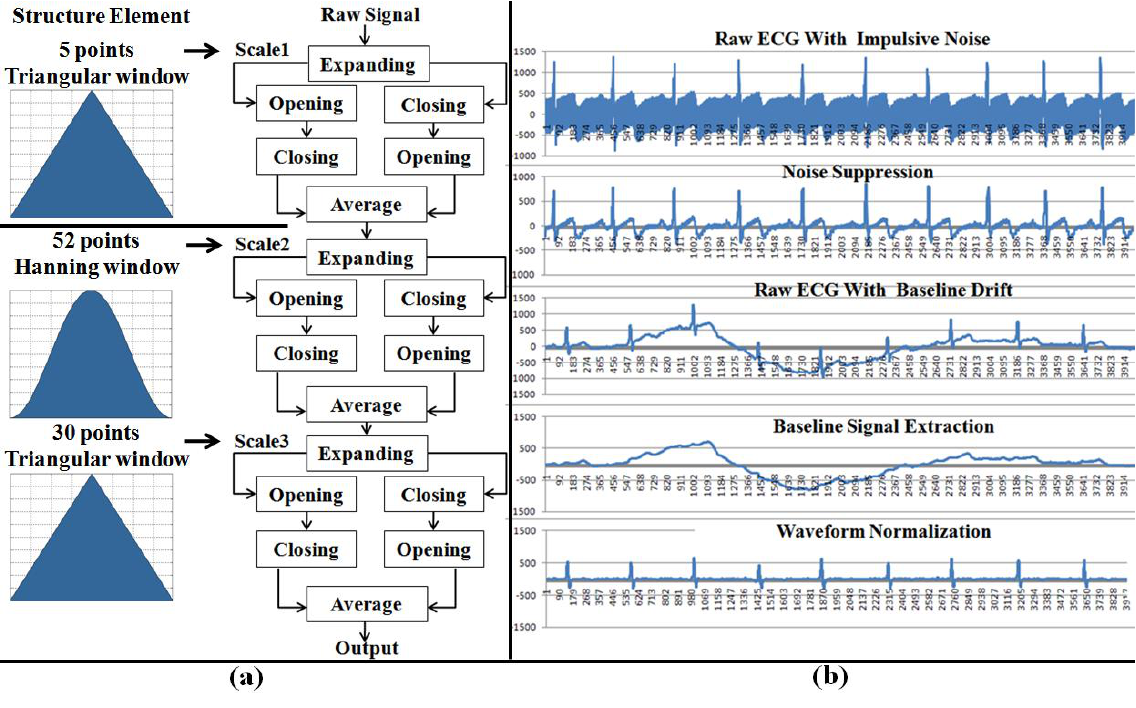
Figure 5. The structure of 3M filter and corresponding filter effects. ( a ) the structure element in different scales (scale 1 for impulsive noise suppression; scale 2 and 3 for waveform normalization); ( b ) filter effects during the stage of impulsive noise suppression and waveform